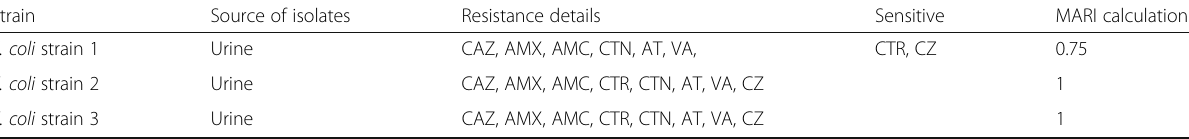
Table 2 Susceptibility details of E. coli isolates towards different antibiotics Strain Source of isolates Resistance